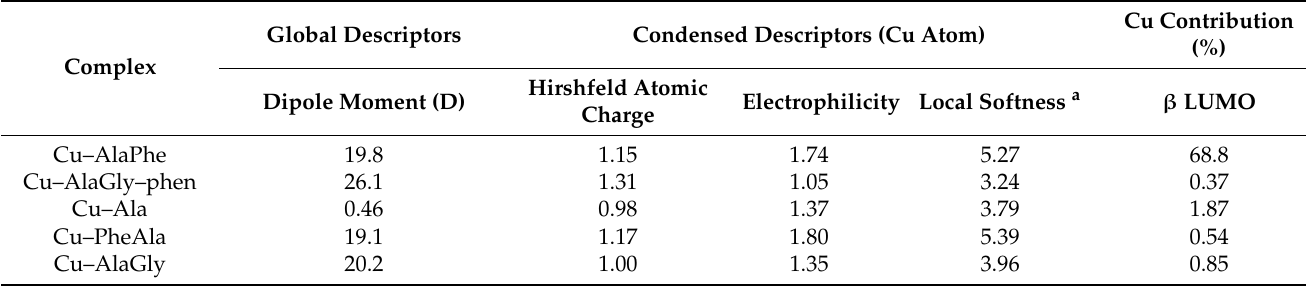
Table 3. Reactivity descriptors. The complexes are ordered from high to low in terms of SOD-like activity. Global Descriptors Complex